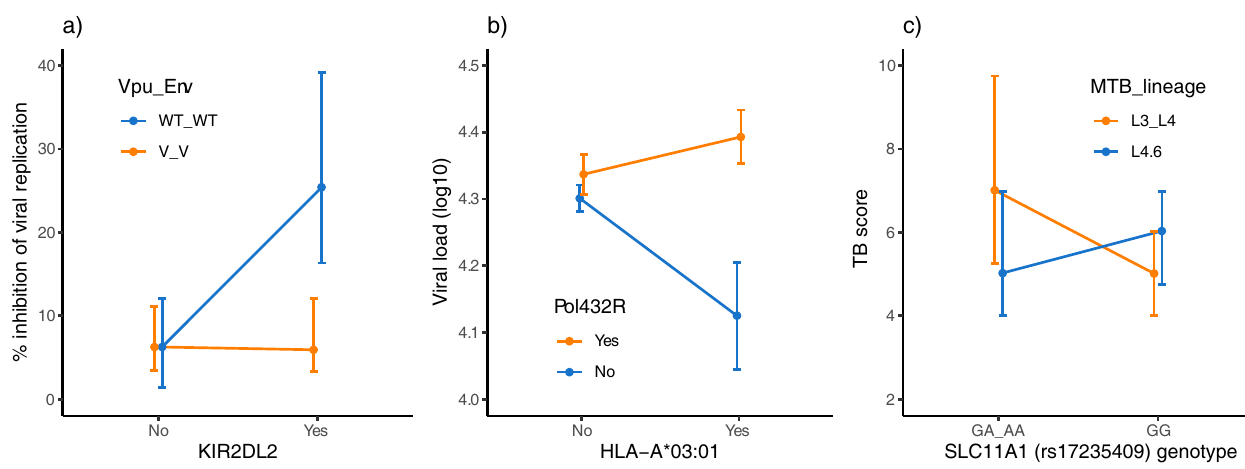
Fig 2. Examples of G × G for continuous traits related to resistance/susceptibility to infectious disease. (a) G × G between NK cell Killer Immunoglobulin Receptor genotype and HIV genotype for inhibition of viral replication (median ± interquartile range). NK cells with the KIR2DL2 allele strongly inhibit replication of HIV with wild-type alleles at vpu and env (WT_WT) but have limited inhibitory effect on HIV with variant alleles (V_V), while NK cells without KIR2DL2 have limited inhibitory effect on both WT_WT and V_V. Thus, presence/absence of KIR2DL2 affects the range of HIV genotypes an individual is susceptible to, consistent with the GFG scenario. Data extracted from Fig 1B (day 3) of [34]. (b) G × G between HLA-A genotype and HIV genotype for viral load (mean ± SE). Arginine (R) at residue 432 in the pol gene is an immune escape mutation from the HLA-A allele 03:01. In individuals carrying A � 03:01, viral load is suppressed in infections with virus without the Pol432R escape mutation, while there is no effect of Pol432 genotype on viral load in individuals without A � 03:01 (and no G × G for viral load between Pol432 genotype and other HLA alleles). Thus, there is no indication of a trade-off between resistance to Pol432R and other genotypes as would be the case in an MA type G × G; instead the pattern is consistent with a GFG type G × G. Data from [32]. (c) G × G between SLC11A1 genotype and M . tuberculosis lineage for tuberculosis severity (median ± IQR). A recently evolved M . tuberculosis sublineage (L4.6) in combination with homozygosity for an ancestral SLC11A1 allele (genotype GG) and an original M . tuberculosis lineage (L3 or L4) in combination with � 1 derived SLCA11A1 allele (genotype GA or AA) is associated with more severe disease than the other combinations of host and pathogen genotypes (the interaction is highly significant: P = 0.00022). Thus, there is a trade-off between resistance to disease by different lineages, consistent with an MA type G × G. Data extracted from Fig 2 in [35]. GFG, gene-for-gene; G × G, host genotype-by-pathogen genotype interaction; MA, matching